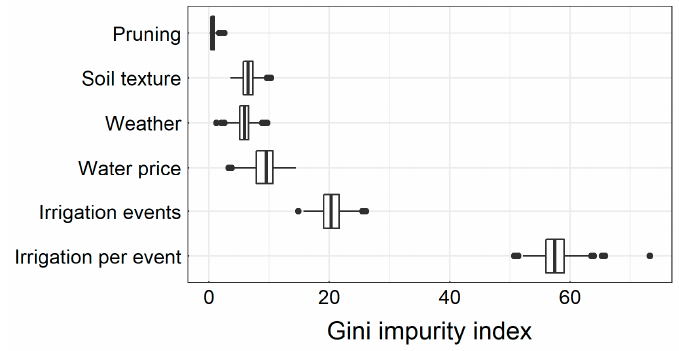
Figure 5. Gini index for the variables of the decision tree. Boxes depict the range of the 25–75% percentile of variable Gini’s importance over all training iterations, and the bar is the median value. The whiskers depict the minimum and maximum values and the dots are outliers.